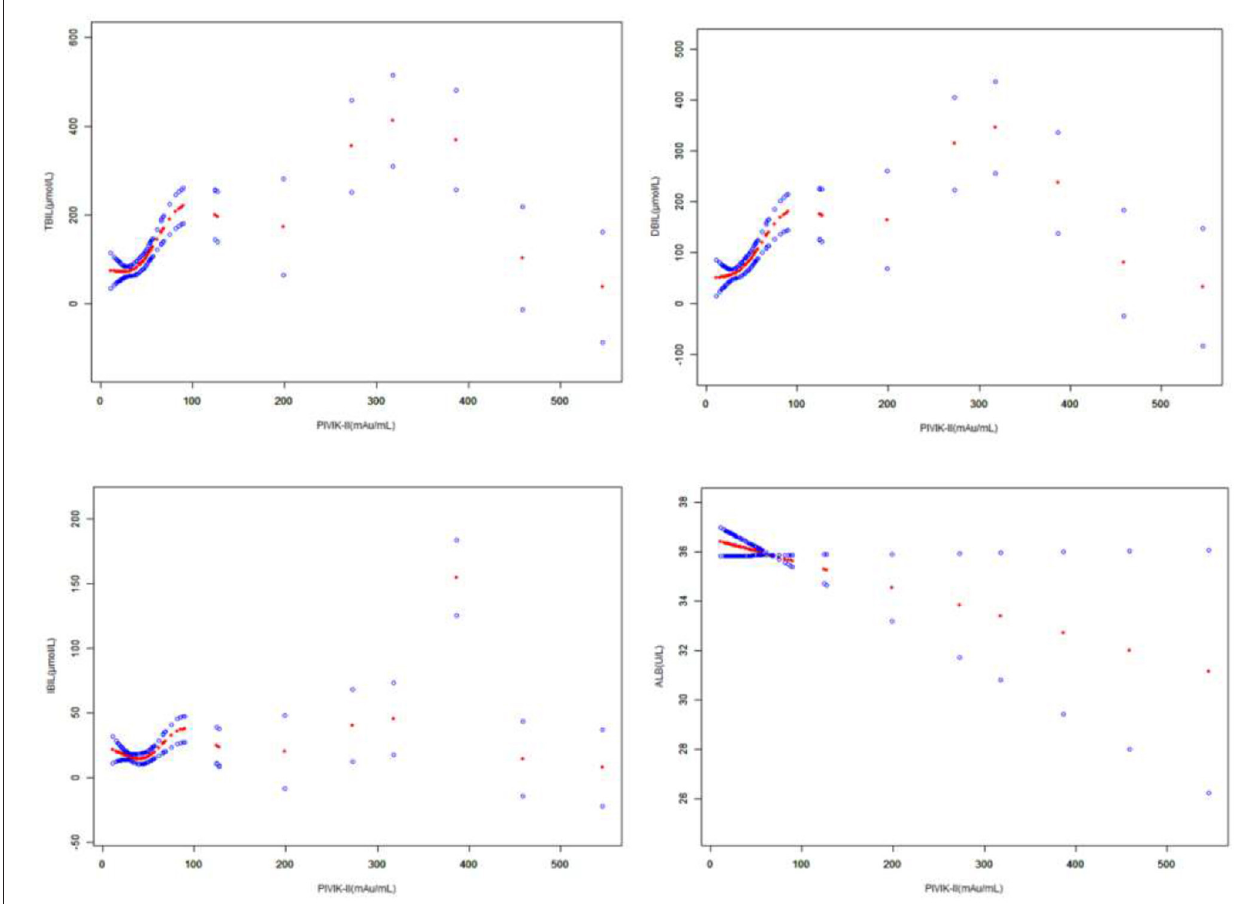
FIGURE 4 | The correlation between PIVKA-II and bilirubin and albumin. The solid red line represents the smooth curve fit between variables. Blue bands represent the 95% CI from the fit. Gender and age were adjusted. PIVKA, protein induced by vitamin K absence or